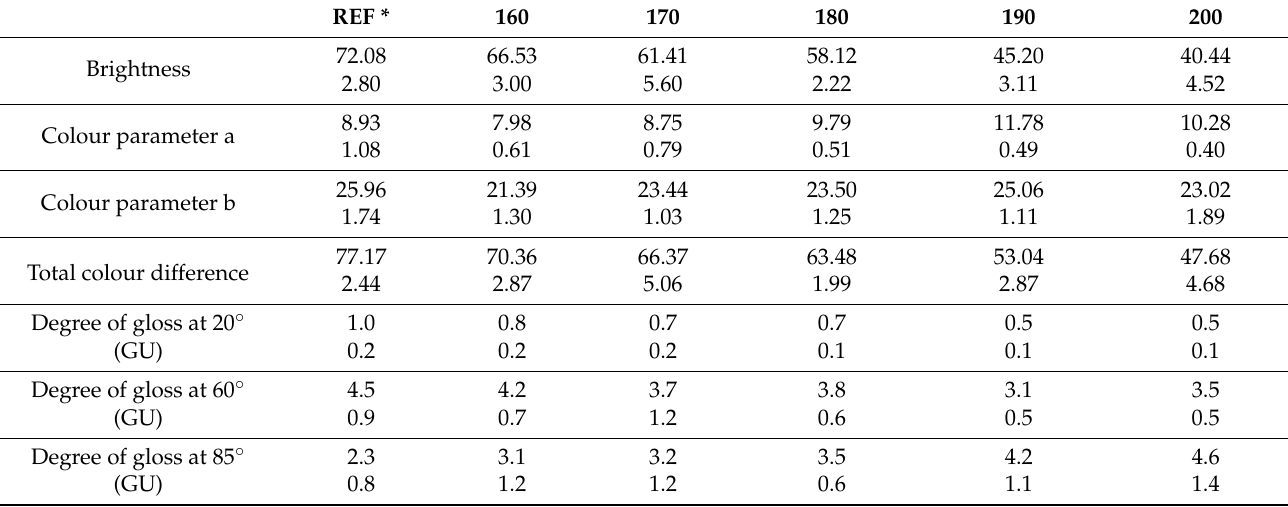
Table 2. Descriptive statistics (Mean value and Standard deviation) of colour and gloss parameters for unmodified birch wood and individual stages of heat-treated birch wood; including defects.